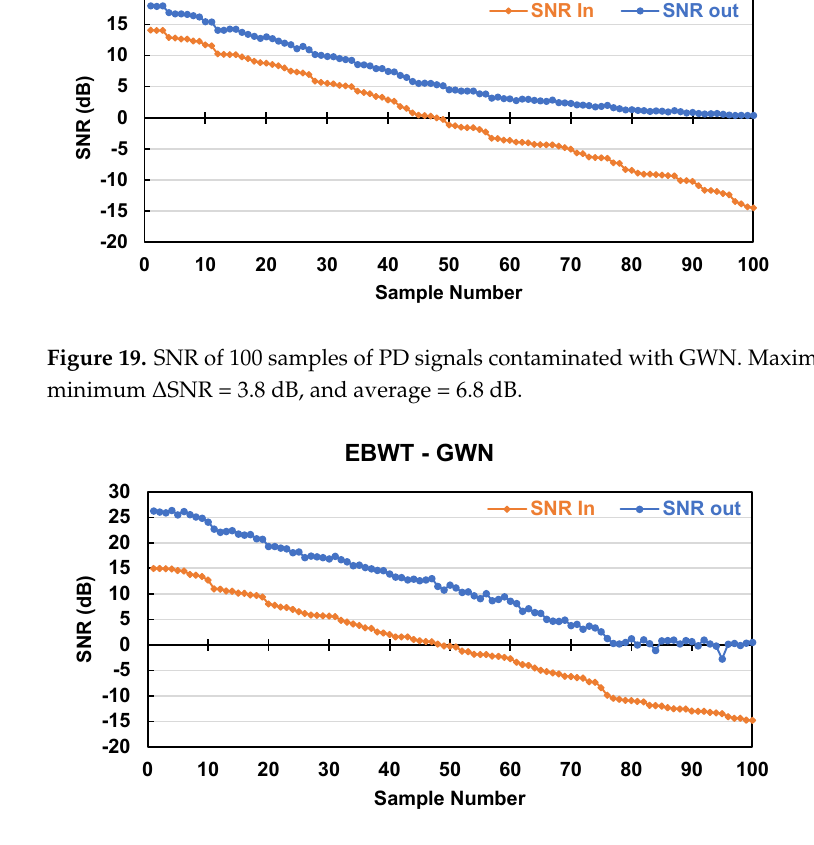
Figure 20. Output SNR using EBWT versus the input SNR of 100 samples of PD signals contaminated with GWN. Maximum ∆ SNR = 15.29 dB and minimum ∆ SNR = 9.6 dB; average = 11.7 dB.